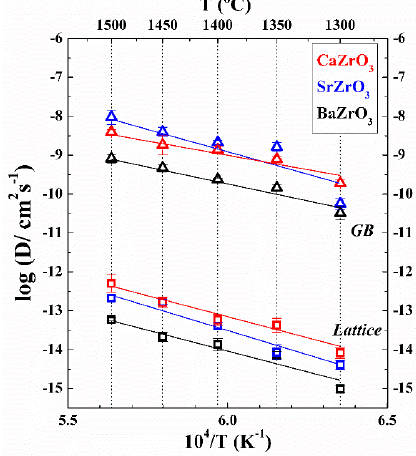
Figure 3. Arrhenius plot of the 96 Zr diffusion coefficients in AZrO 3 (A = Ca, Sr, Ba). The uncertainty for each data point is the standard deviation obtained by the fitting of the depth profiles. Table 2. The pre-exponential factor and activation energy for 96 Zr lattice and grain boundary diffusion